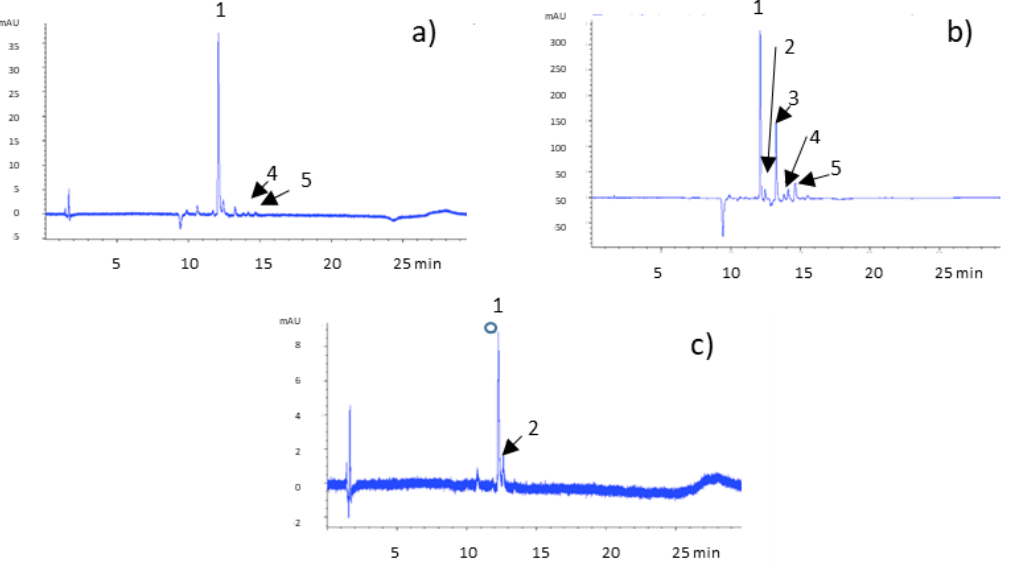
Figure 1. Chromatogram of A. cepa Golden variety extracts recorded at 370 nm. ( a ) Tunicate bulb extract, ( b ) tunic extract, and ( c ) bulb extract. Peaks shown are: (1) quercetin 3,4 ’ -diglucoside, (2)